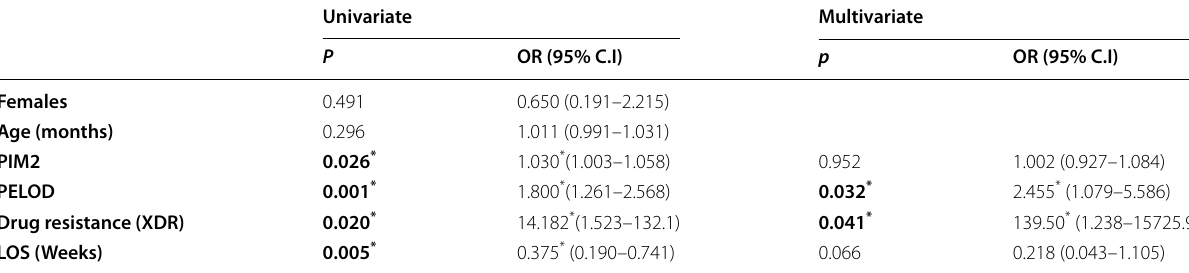
OR odd’s ratio, C.I confidence interval, LOS length of stay, XDR extensive drug‑resistance, PIM2 pediatric index of mortality 2, PELOD pediatric logistic organ dysfunction * p value